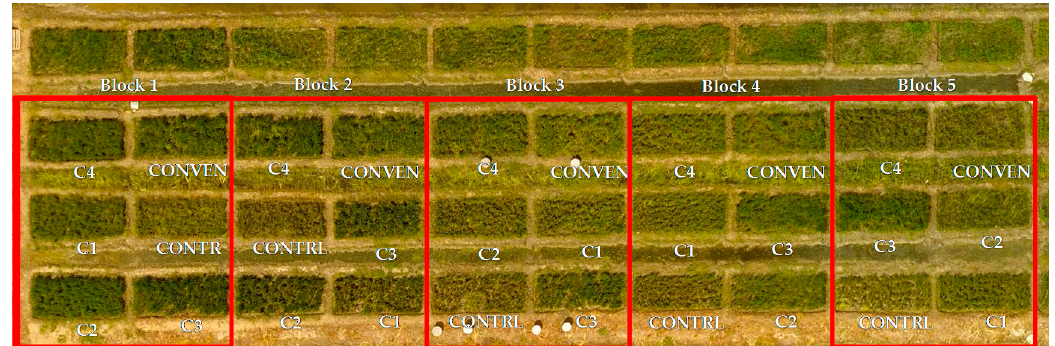
Figure 2. Experimental setup (RGB image taken by drone). Differences between fertilization treatments in biomass and green color are visible from early stages.